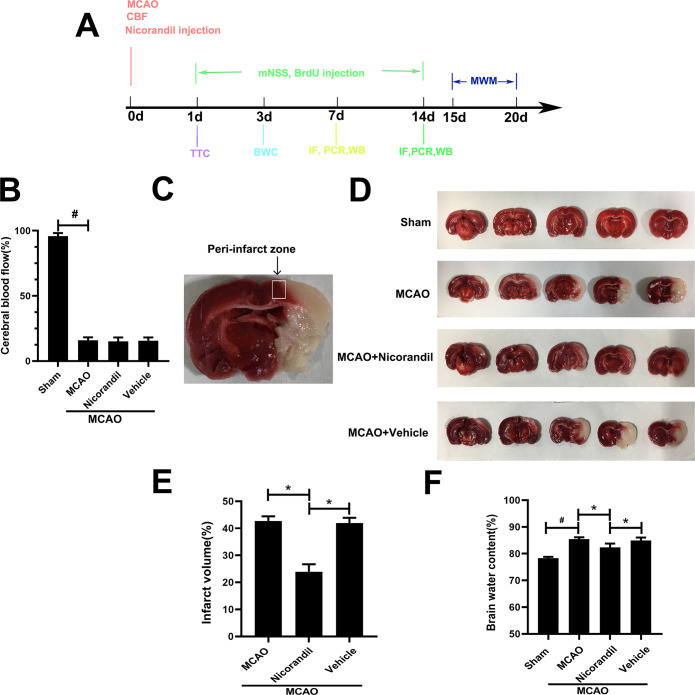
The nicorandil treatment alters the infarct volume and brain water content after MCAO.(A) Schematic representation of experimental design. (B) Changes of cerebral blood flow (CBF) of all groups. #p<0.05 compared with the Sham group, n = 56/group. (C) Representative image of the peri-infarct zone. (D) Representative TTC staining in each group at 24 h after MCAO. (E) Analysis of the infarct volume of all groups, *p<0.05, n = 6 rats per group. (F) Quantification of the brain water content. Data are presented as means ± SD. *p<0.05 compared with the MCAO group and MCAO+Vehicle group; #p<0.05 compared with the Sham group, n = 6 rats per group.